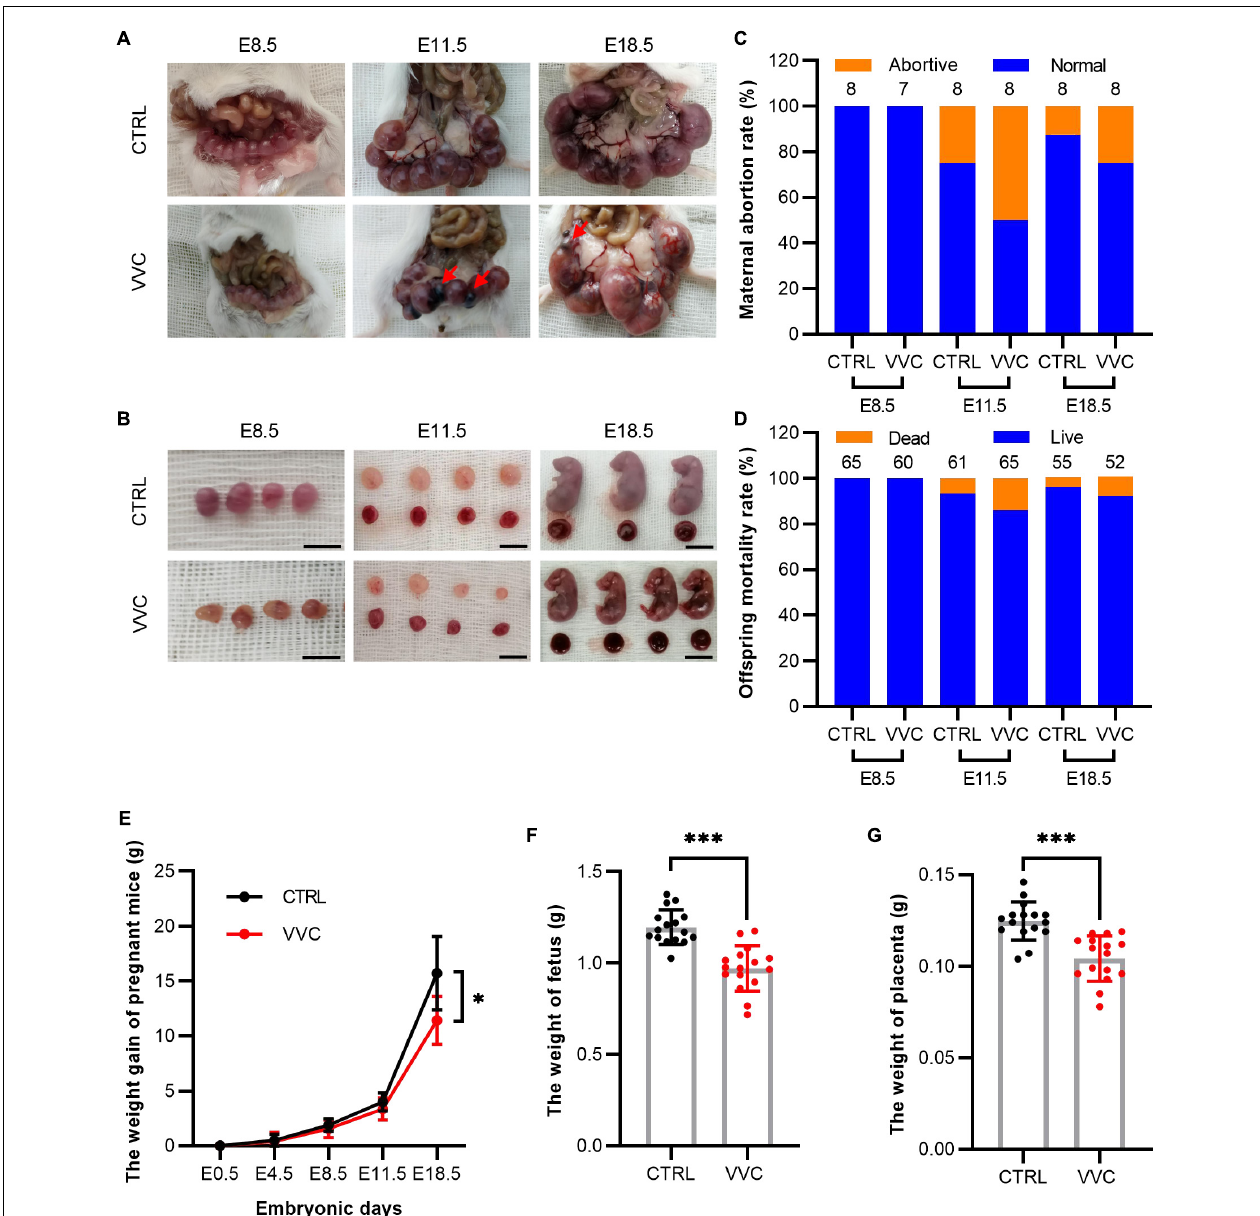
FIGURE 2 | Characteristics of pregnancy outcomes in the VVC group and the control group. (A,B) Representative images of embryos and placentas by integral view (A) and local view (B) at E8.5, E11.5, and E18.5, respectively. Red arrows indicate resorbed embryos. Scale bar: 1.0 cm. (C,D) The maternal abortion rate (C) and the offspring mortality rate (D) in the VVC group and control group at E8.5, E11.5, and E18.5. Numbers of mice in the control group: E8.5 n = 8, E11.5 n = 8, E18.5 n = 8. Numbers of mice in the VVC group: E8.5 n = 7, E11.5 n = 8, E18.5 n = 8. (E) Weight recorded of pregnant mice in the VVC group and control group at E0.5, E4.5, E8.5, E11.5, and E18.5. Numbers of mice in the control group: E4.5 n = 24, E8.5 n = 24, E11.5 n = 16, E18.5 n = 8. Numbers of mice in the VVC group: E4.5 n = 23 E8.5 n = 23, E11.5 n = 15, E18.5 n = 8. (F) Weight of fetus in the VVC group and control group by cesarean section at E18.5 ( n = 16). (G) Weight of the placenta in the VVC group and control group by cesarean section at E18.5 ( n = 16). Data are presented as mean ± SD. Unpaired t -test was used for two-group comparisons of the pregnant mouse bodyweight, the weight of fetus, and the weight of the placenta. Fisher’s exact test was used for two-group comparisons of